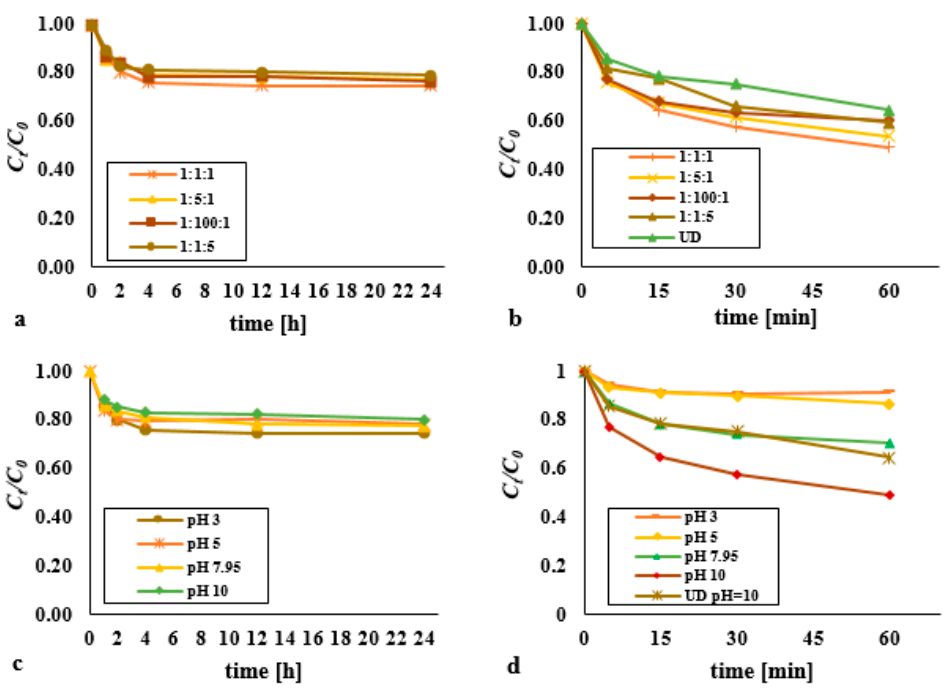
Figure 3. Impact on the decomposition of DEHP using ( a ) a modified Fenton process with various dosages (at pH = 3); ( b ) a modified Fenton process with various doses supported by an ultrasonic field (pH = 10, acoustic wave intensity of 3.97 W/cm 2 ); ( c ) a modified Fenton process in various pH (molar ratio DEHP:H 2 O 2 :Fe 3+ 1:1:1); ( d ) a modified Fenton process supported by an ultrasonic field in various pH (molar ratio DEHP:H 2 O 2 :Fe 3+ 1:1:1, acoustic wave intensity of 3.97 W/cm 2 ).